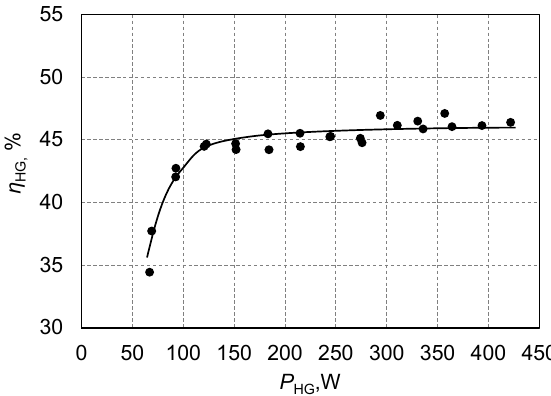
Figure 4. Hydrogen generator efficiency as a function of supply power.